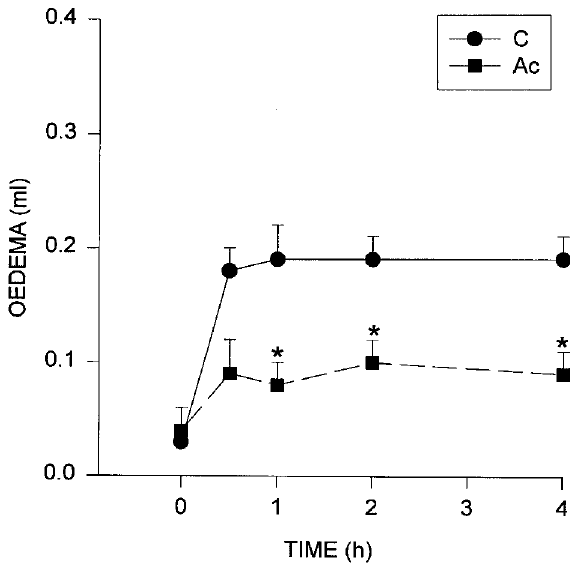
FIG. 4. Reduction of oedematogenic response to SEA sensitization by an antibody anti-IL-1 b . The antibody was injecteds.c. 30min before injection of the antigen. Measure- ments were obtained in a hydroplethysmother (Ugo Basile) at zero, 15, 30, 60, 120, 240min and 24h following admin- istration of the antigen ( n =4–5). Statistical significance is indicated by * P <0.05 (Anova t